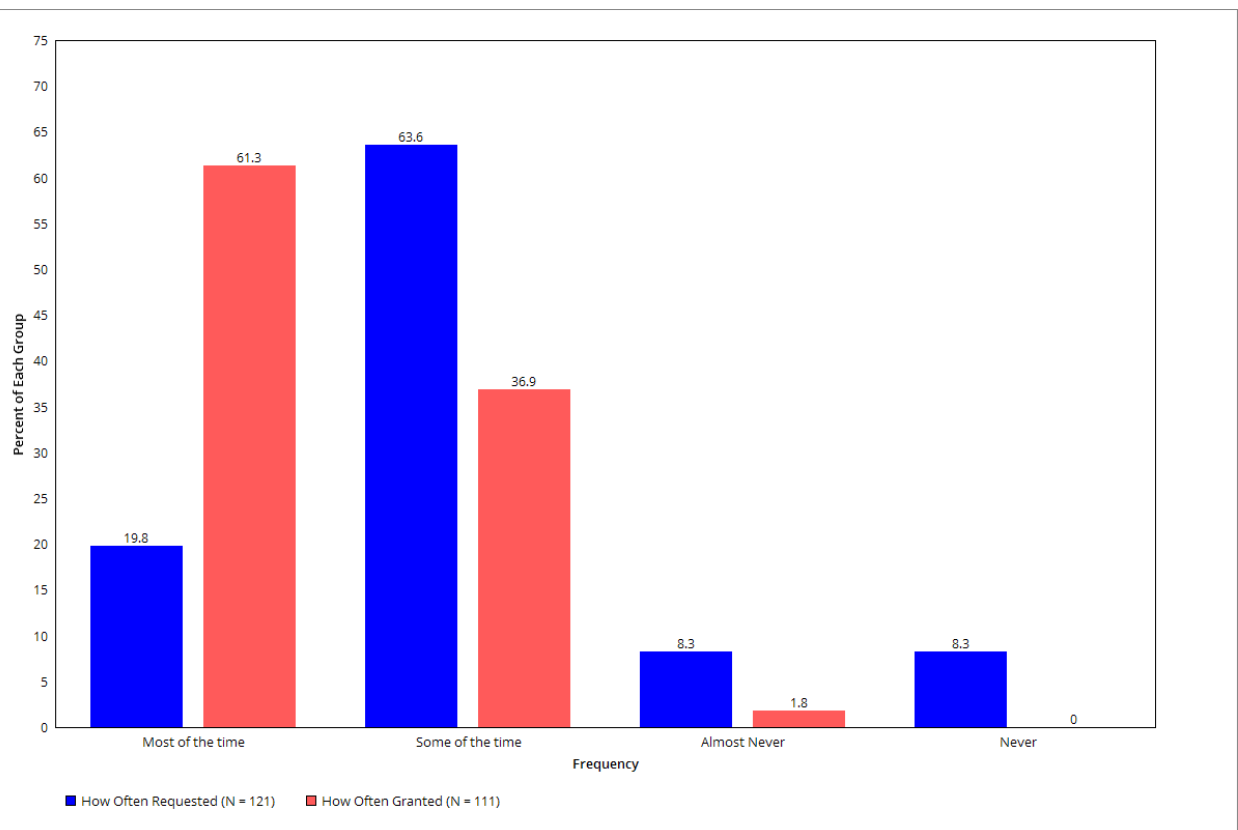
Figure 3. How Often Financial Waivers are Requested and